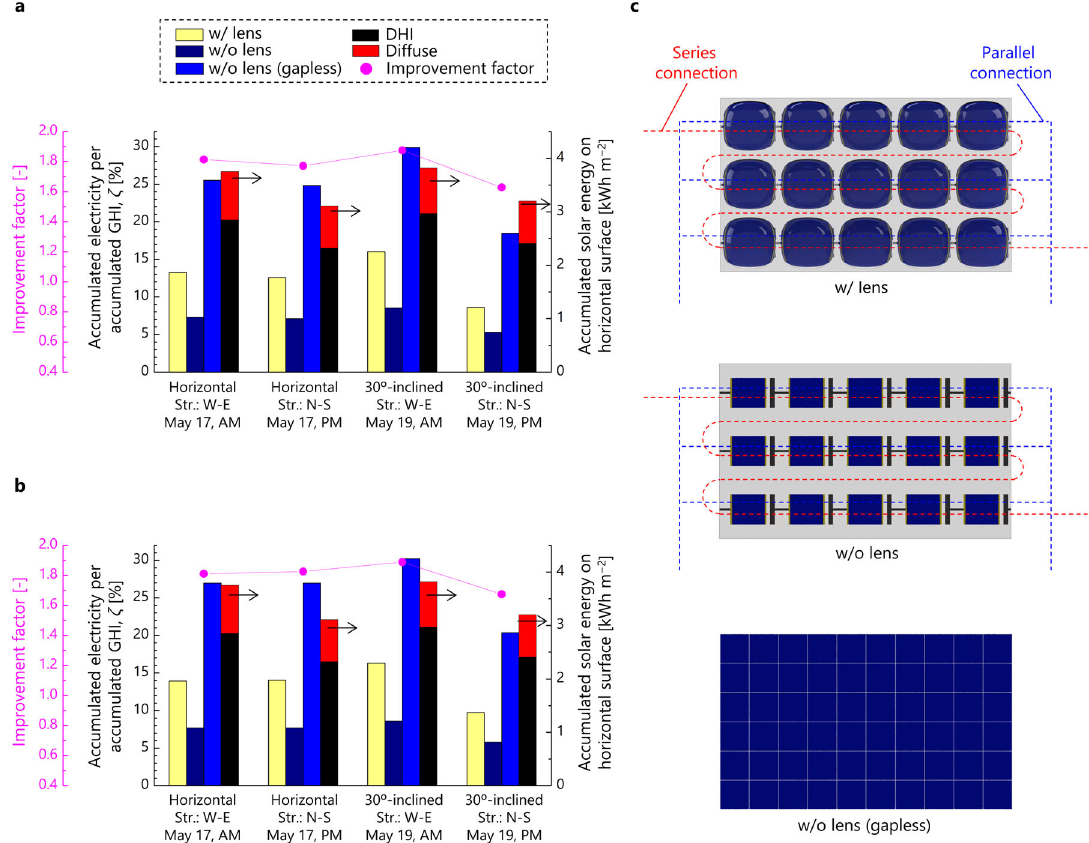
Fig. 6 Accumulated electricity per module area / accumulated GHI ratio. a , b Results obtained from the three strings in the series- and parallel-connected cases, respectively. For the module without lens (w/o lens), the projected total electricity for a gapless case is also shown. The improvement factor was de fi ned as ζ (w/ lens) / ζ (w/o lens). Global horizontal irradiance (GHI) is sum of direct horizontal irradiance (DHI) and diffuse irradiance. c Schematic of the top view of the three module con fi gurations (w/ lens, w/o lens, and w/o lens (gapless)) in the same module area. String connections are also shown (series connection, red; parallel connection,